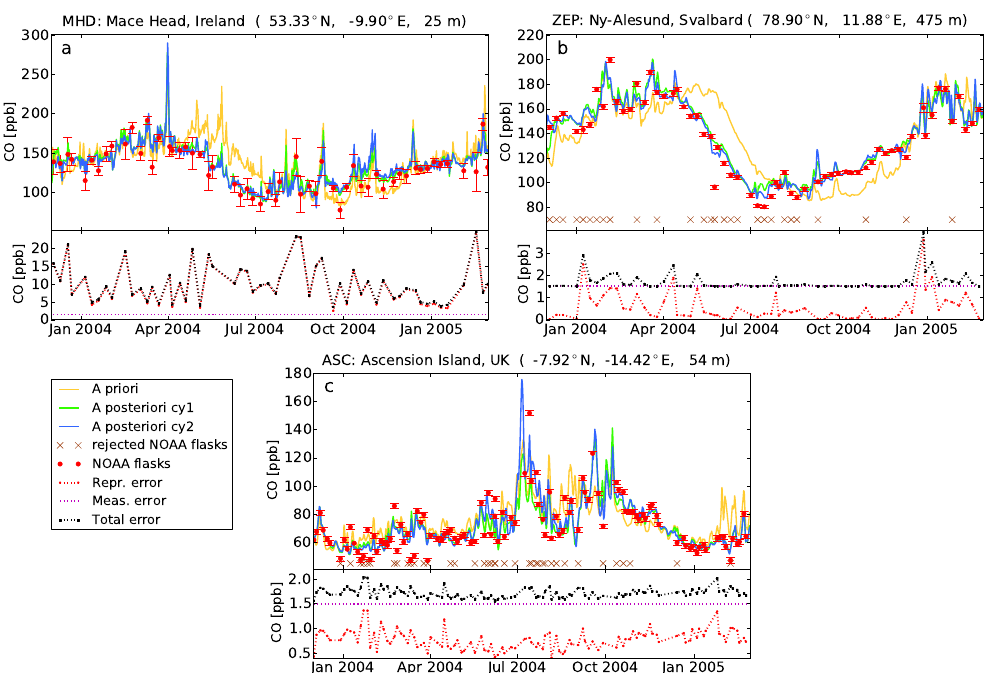
Fig. 7. Top: prior (yellow) and posterior (cycle 1 (green) and cycle 2 (blue)) simulations for (a) Mace Head, Ireland, (b) Ny-Alesund, Svalbard and (c) Ascension Island. The NOAA flasks are shown in red. Rejected observations from cycle 1 to cycle 2 are represented by dark red crosses. Bottom: the observation error is divided in its fixed part (purple) and the model error (red). The total error is shown in